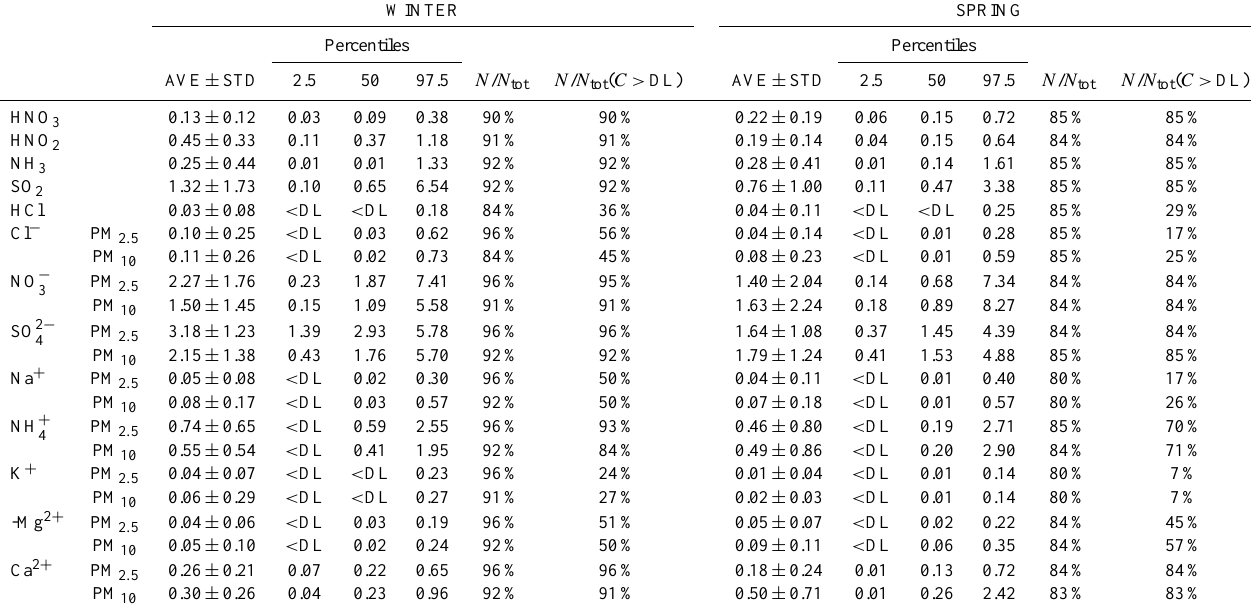
Table 2. Statistical summary of the MARGA data measured at SMEAR III station in Helsinki in winter (1 November 2009–28 February 2010) and in spring (1 March–25 May 2010). Five first columns: concentrations of gases in ppb and of aerosols in the two size fractions in µgm − 3 at 20 ◦ C, 1013mbar; N / N tot : fraction of total number of hours during which there is data for the compound; N / N tot ( C > DL): fraction of total number of hours during which concentration was above detection limit. The winter PM 2 . 5 statistics were calculated for the period 19 January–28 February in winter N tot = 2879 for PM 10 and 919 for PM 2 . 5 ; in spring N tot = 2047 for both PM 2 . 5 and PM 10